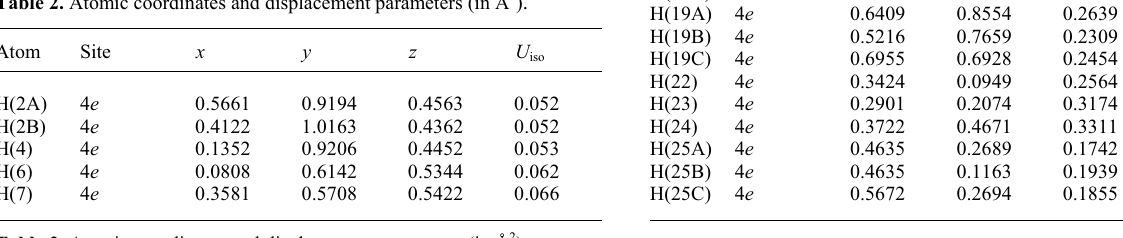
Table 2. Atomic coordinates and displacement parameters (in Å 2 ) .